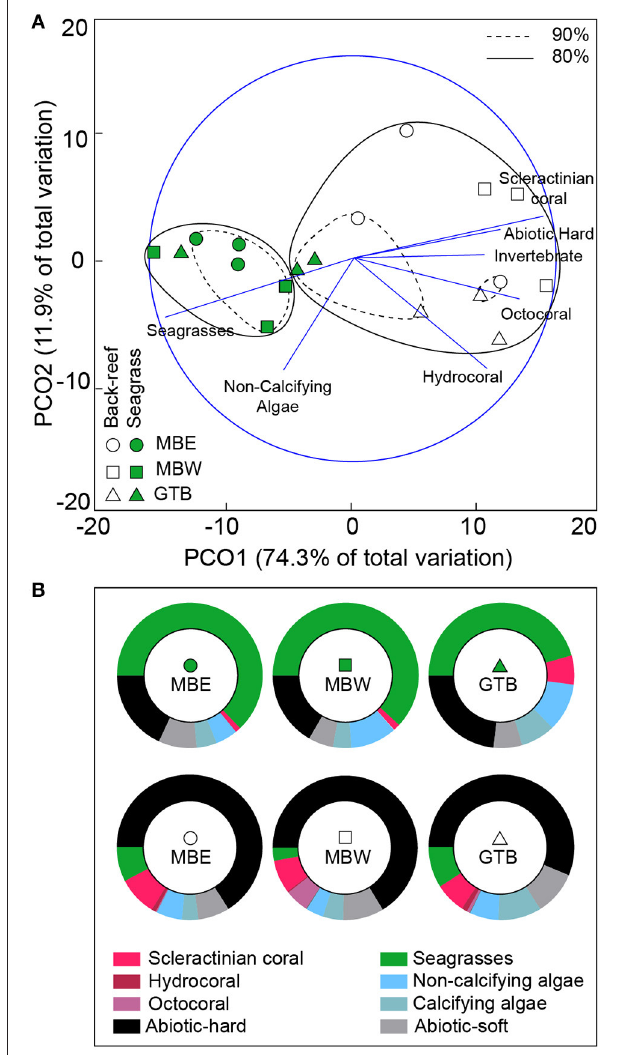
FIGURE 3 | Benthic composition of back-reef and seagrass sites. Principal co-ordinate analysis (PCA) plot (A) of the benthic categories pooled across both 2012 and 2013 (using all species and abiotic categories) per sites with 80% (solid) and 90% (hashed) similarities shown. Pearson’s correlations that exceed R > 0.6 are represented as vectors in blue. The proportional composition of each benthic category pooled across years is shown in (B) . Note: invertebrates other than the Cnidarians are not visible due to their low